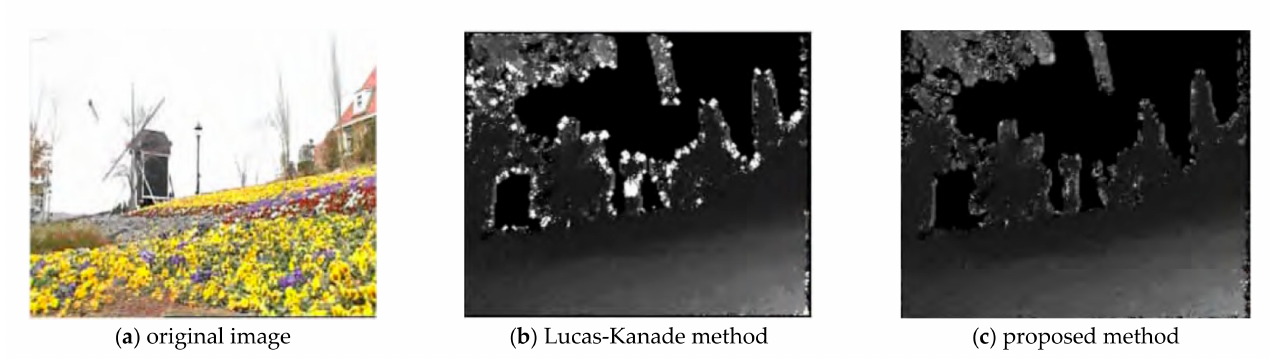
Figure 17. Depth images extracted by different optical flow methods.